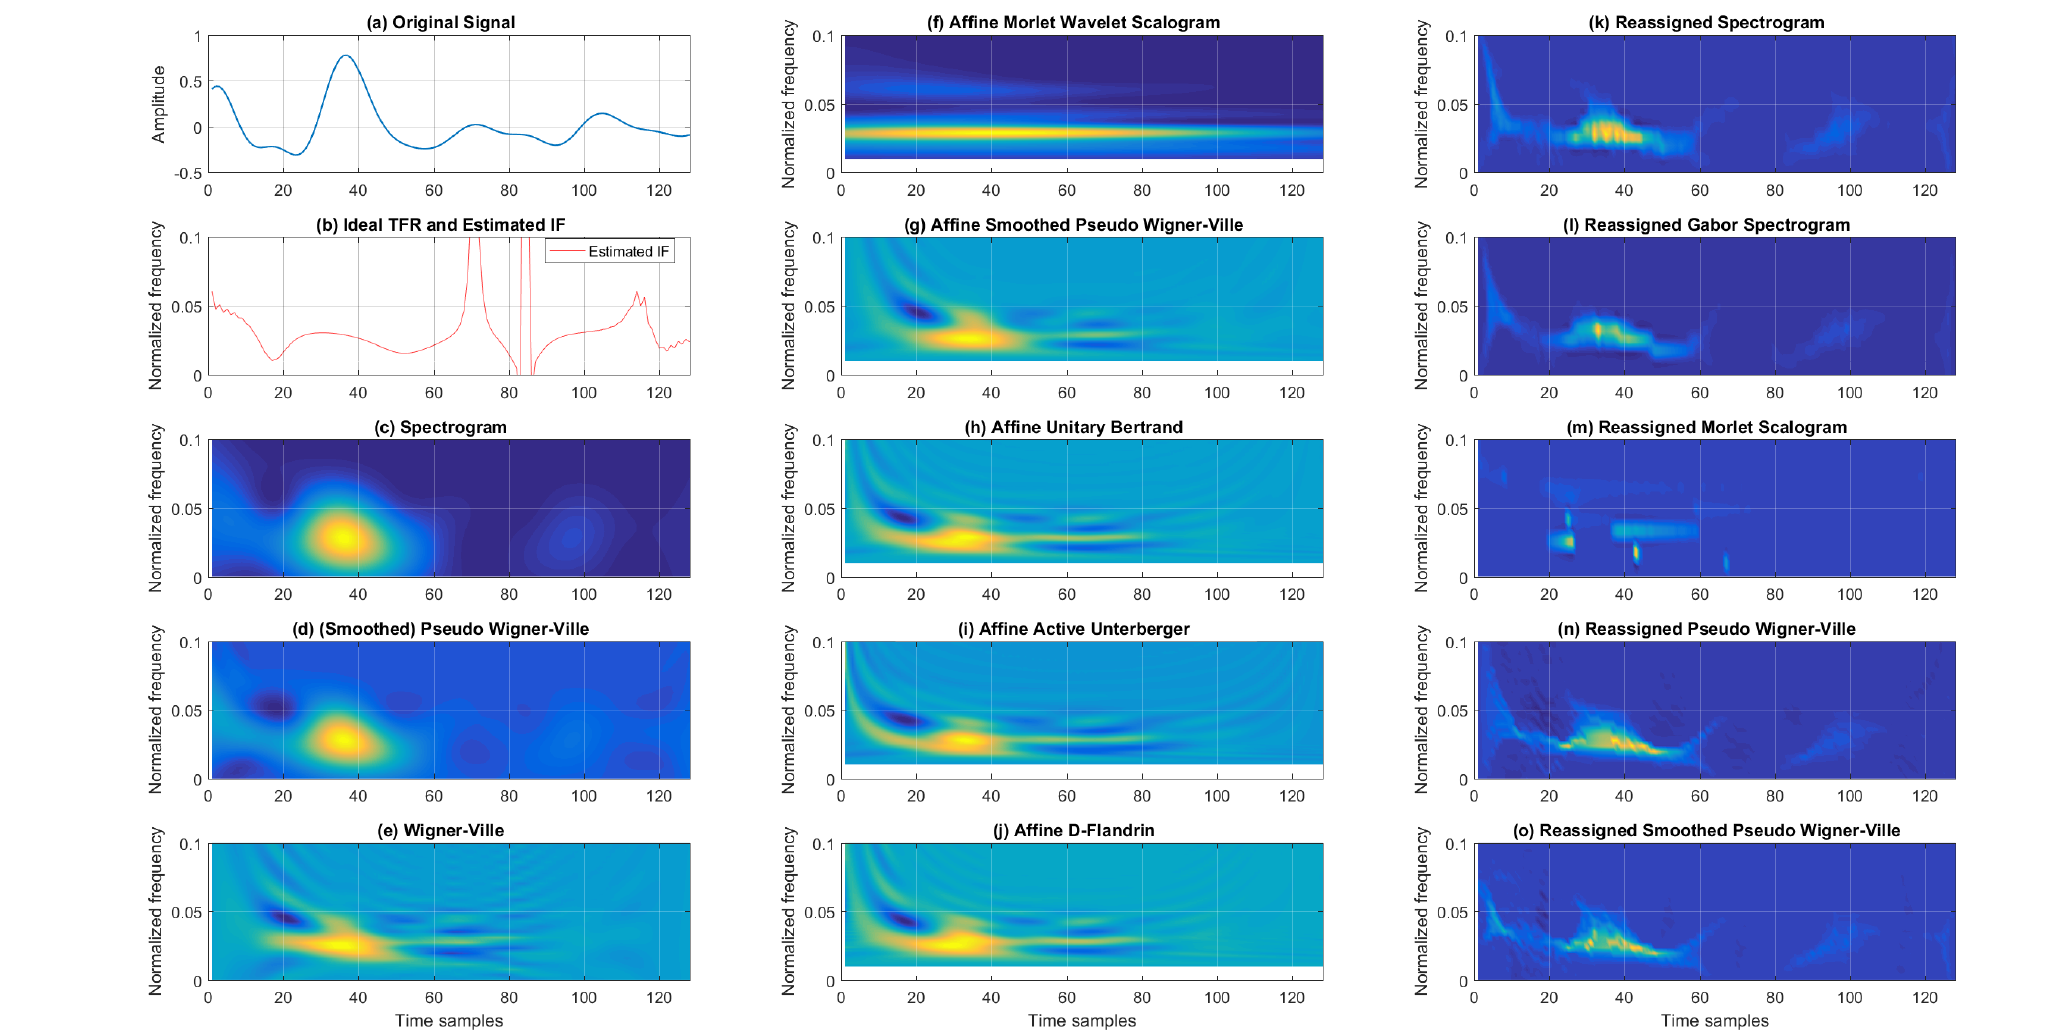
Figure 7. TFRs of an EEG P300 signal for the Cz electrode (averaged over 466